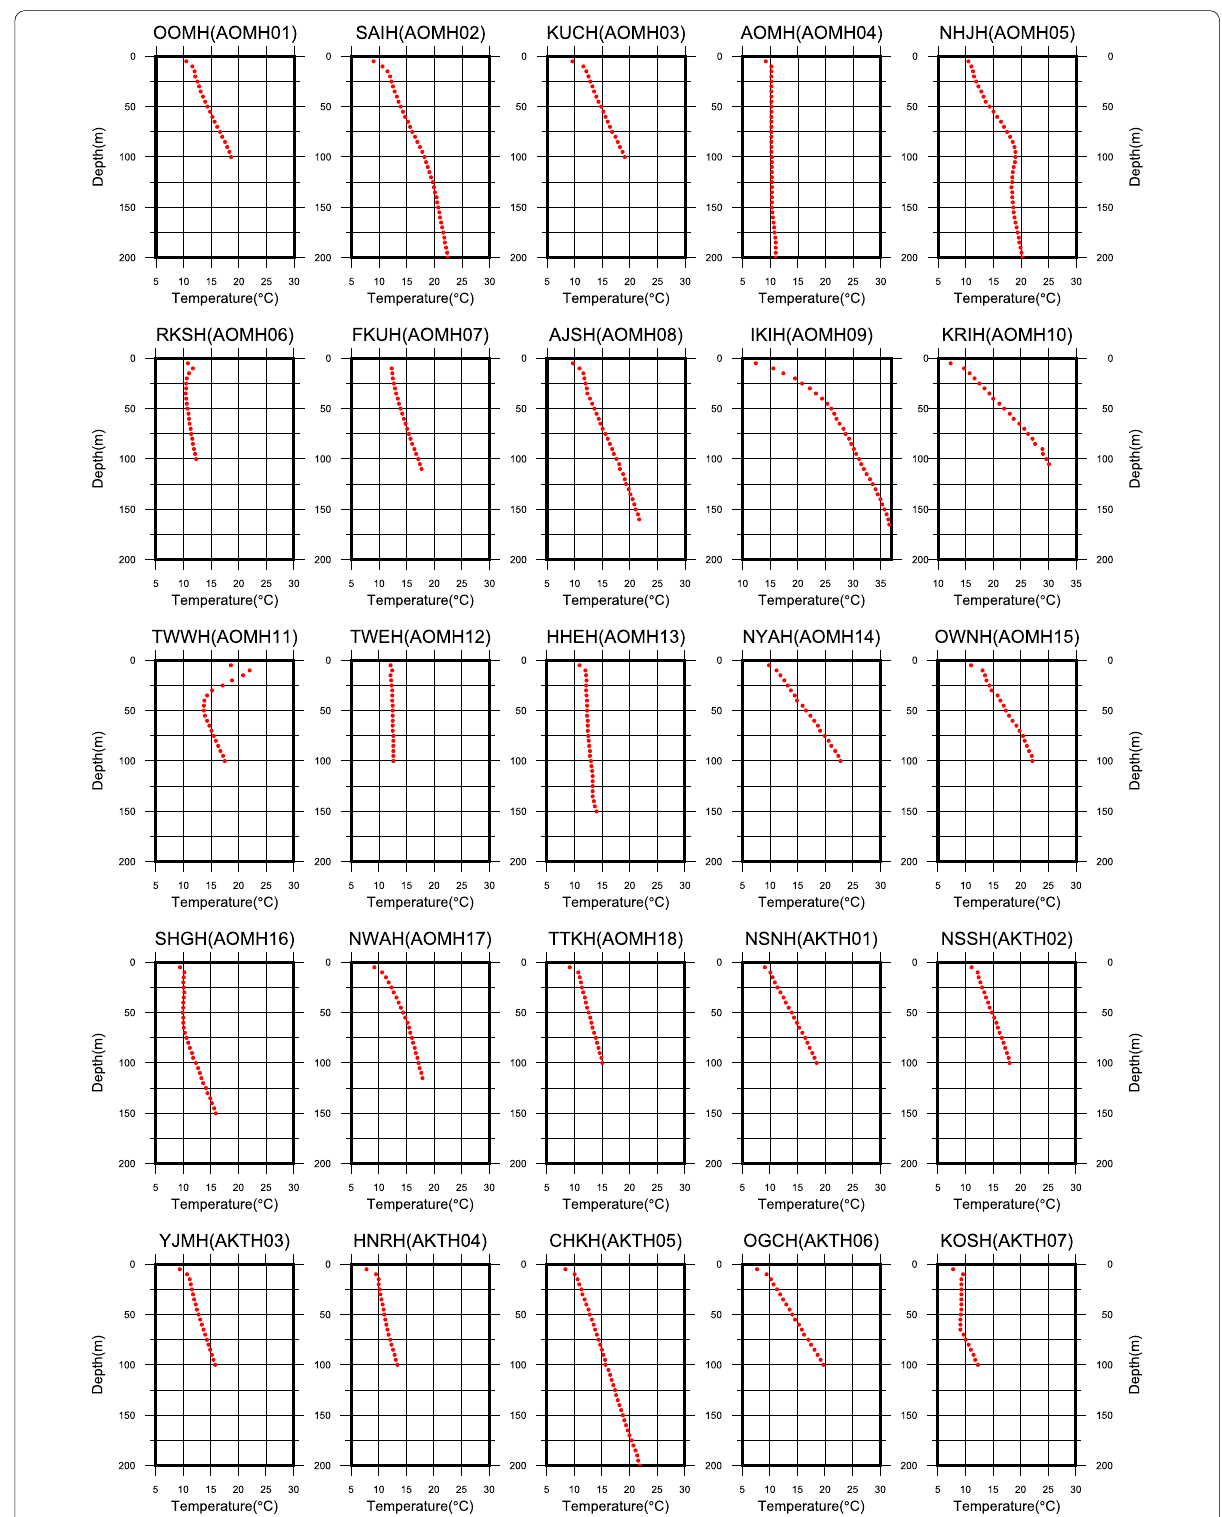
Fig. 2 Temperature profiles of Hi-net boreholes. The red dots show the data from the first temperature logging, and the blue dots show the data from the second temperature logging performed using